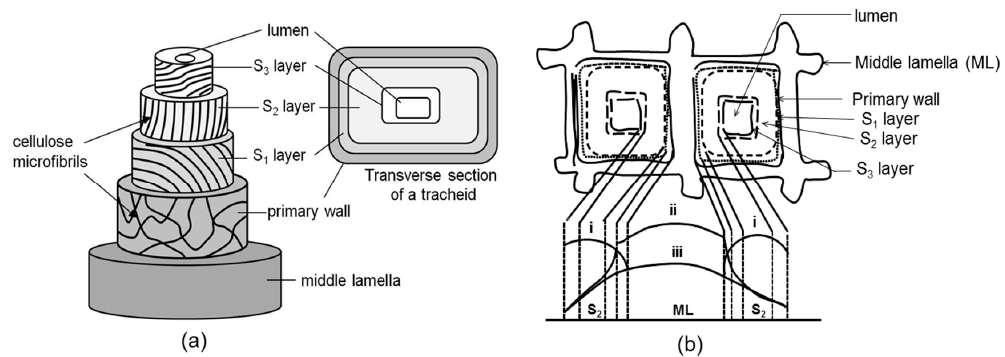
Figure 1. ( a ) Three-dimensional structure of the secondary cell wall of a xylem cell and ( b ) the relative amounts of cellulose, hemicellulose, and lignin across a cross-section of two wood cells (i: cellulose; ii: lignin; and iii: hemicelluloses).